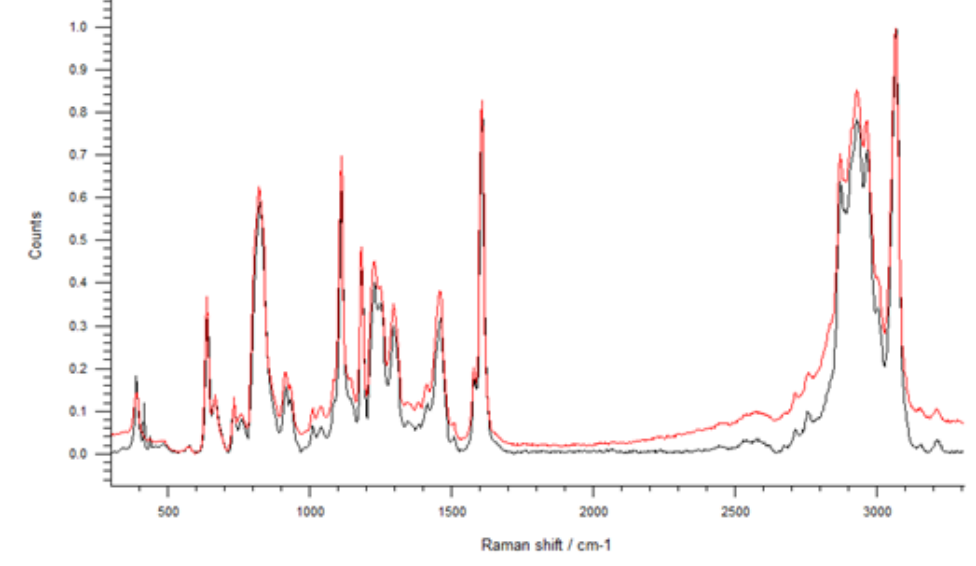
Figure 25. Raman spectrum of epoxy resin before and after aging with KCl .